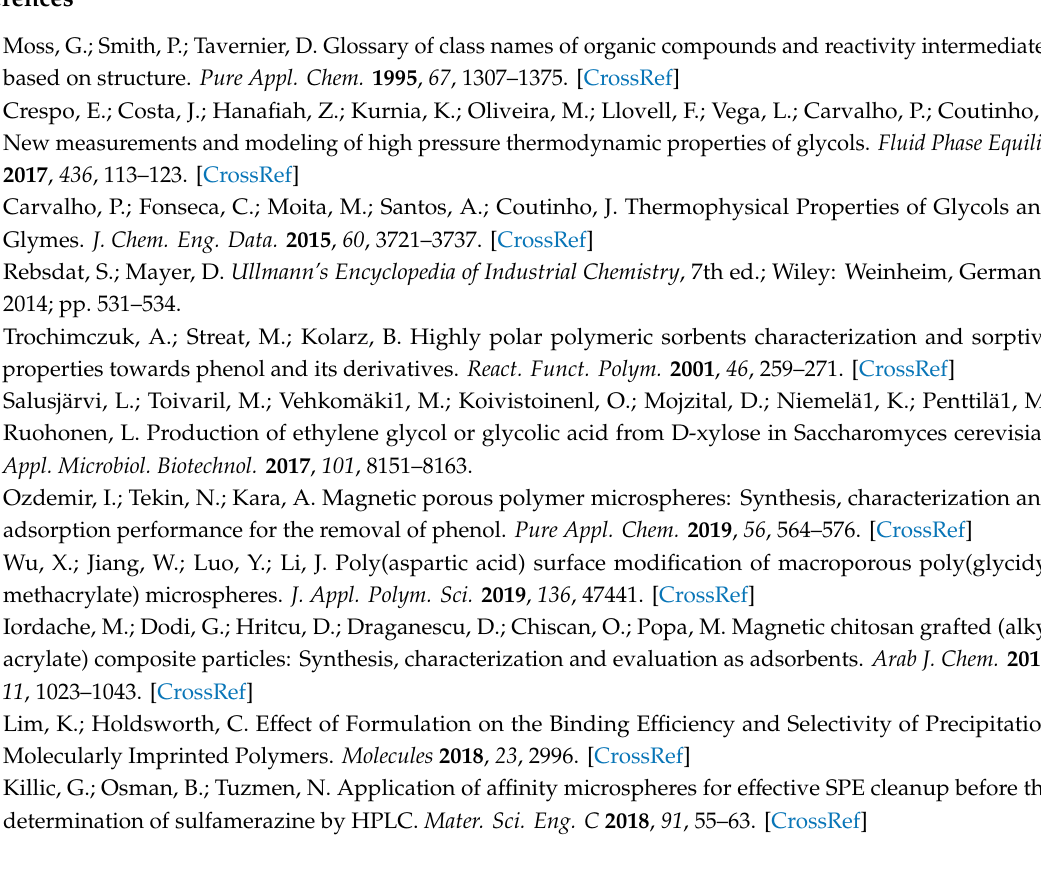
Figure S1. The 2D sketch of the 3D particle and circle equivalent idea, Figure S2. Attenuated Total Reflectance Fourier Transform Infrared (ATR-FTIR) spectra of monomers and copolymer of EGDMA + St, Figure S3. Attenuated Total Reflectance Fourier Transform Infrared (ATR-FTIR) spectra of –OH groups in copolymers and original lignin, Figure S4. Attenuated Total Reflectance Fourier Transform Infrared (ATR-FTIR) spectra of carbonized materials. (a) EGDMA + St + L-N, (b) EGDMA + St + L-C, (c) EGDMA + St + L-Ag, (d) EGDMA + St + L-S, (e) EGDMA + St + L-P, (f) EGDMA + St + L-P2, Table S1. ATR-FTIR spectra of carbonized